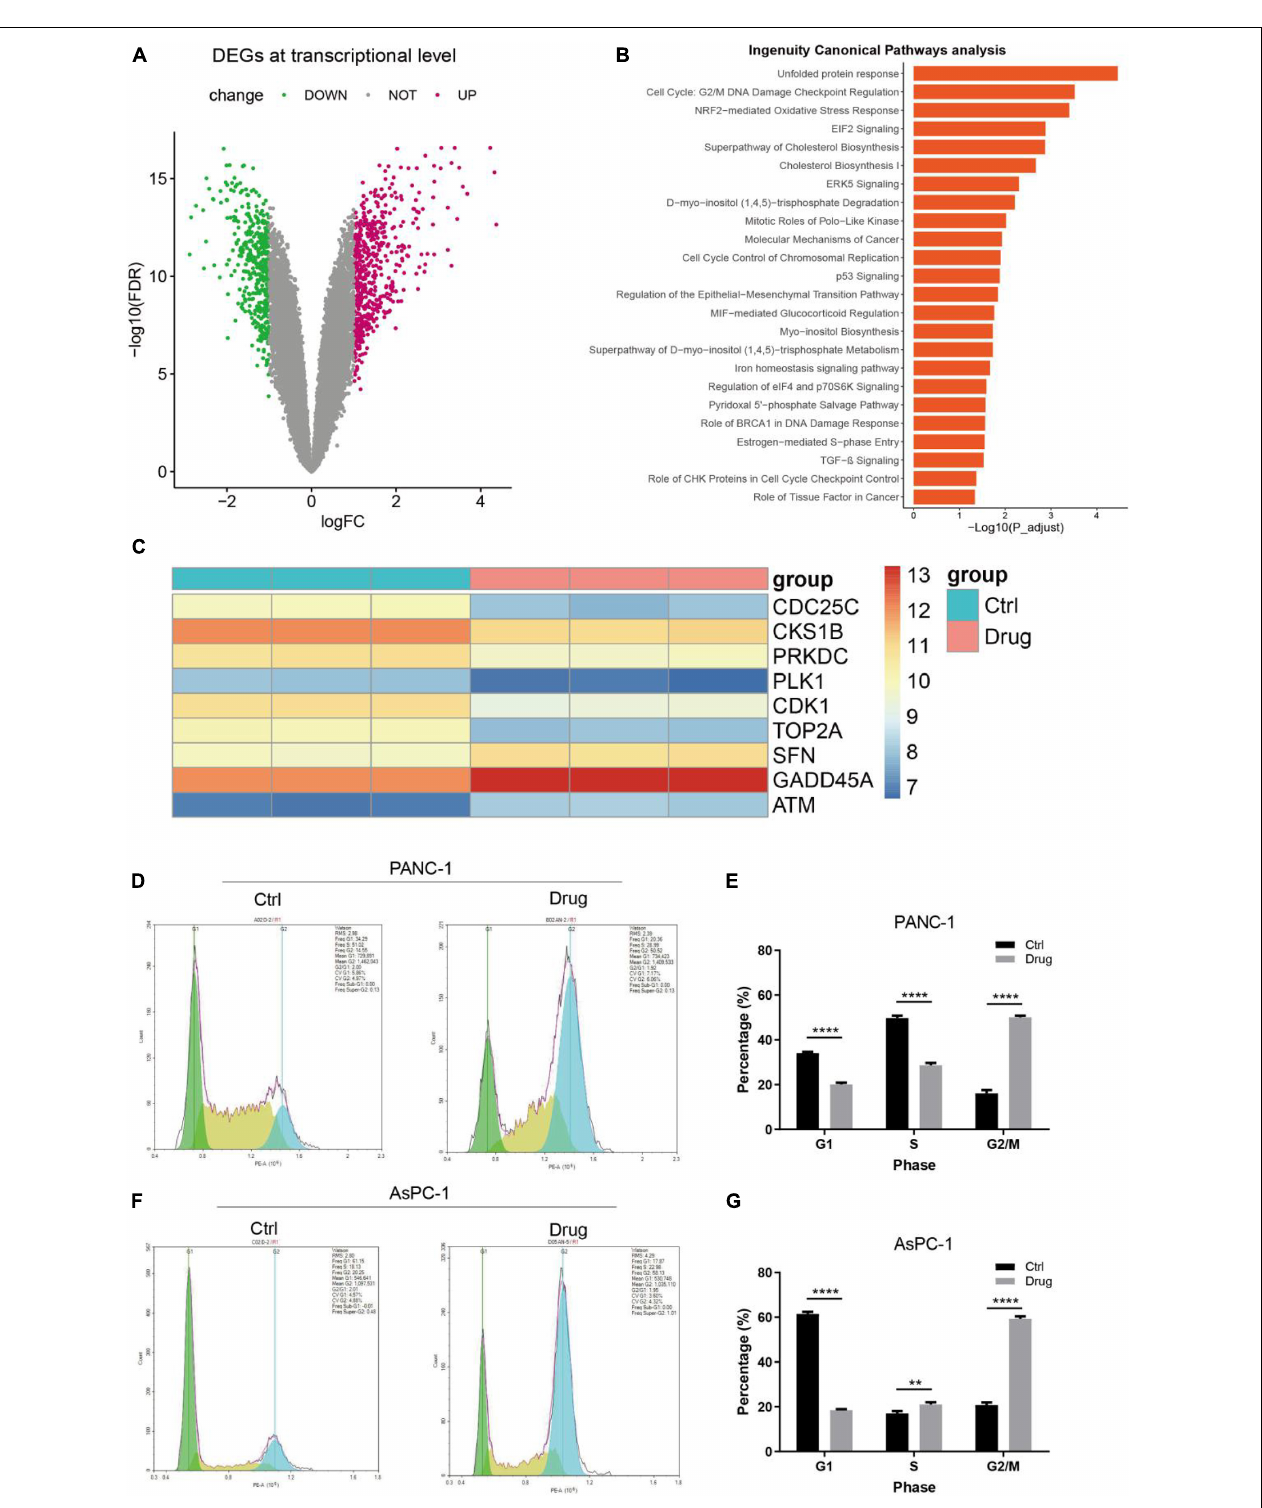
FIGURE 2 | Transcription profiling and canonical pathway analysis. (A) The volcano plot of differentially expressed genes (DEGs) of PANC-1 cells treated with anlotinib. (B) Canonical pathways analysis of the DEGs via the IPA software. (C) The heatmap of the DEGs related to cell cycle: G2/M DNA damage checkpoint regulation . (D,E) Cell cycle assay of PANC-1 cells treated with anlotinib or DMSO. (F,G) Cell cycle assay of AsPC-1 cells treated with anlotinib or DMSO. Data were shown in mean ± SD and p < 0.05 was statistically significant. ** p < 0.01; **** p < 0.0001.